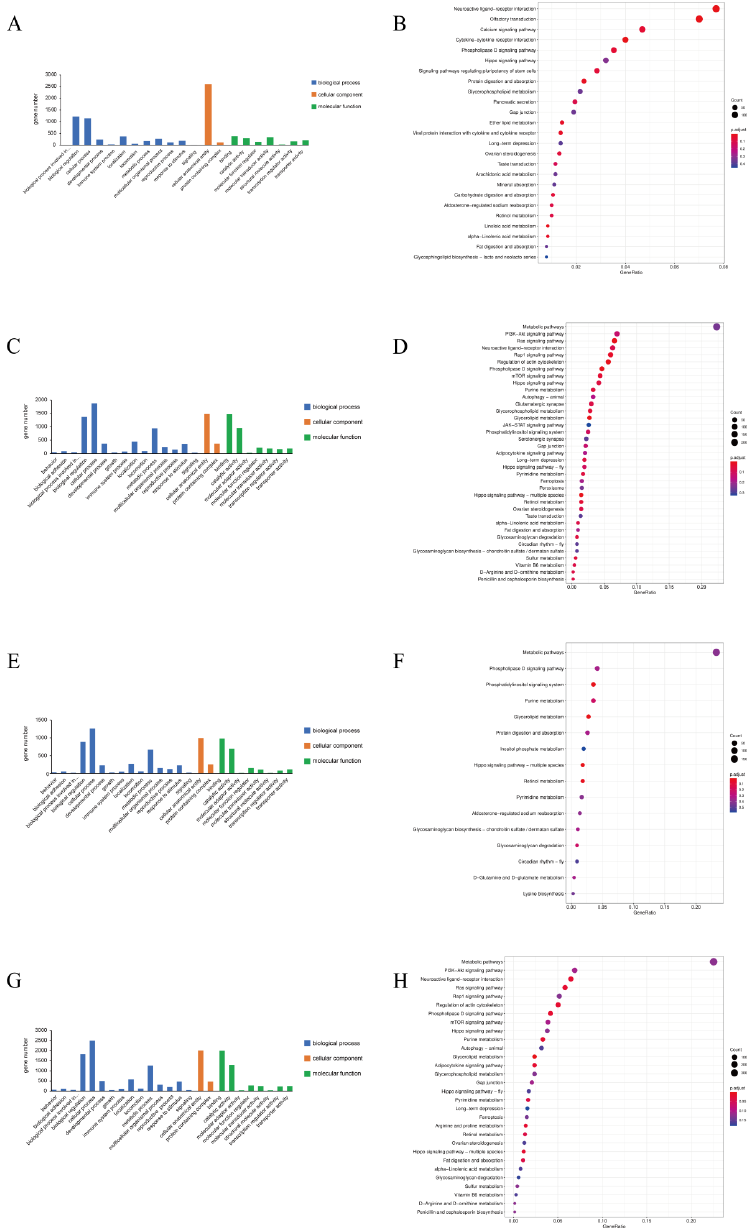
Figure 2. Analyses of functions and pathways of DE mRNAs and ncRNAs. ( A , C , E , G ) signify the GO terms of DE mRNAs, DE lncRNAs, DE circRNAs, and DE miRNAs, respectively. ( B , D , F , H ) illustrate the KEGG signaling pathways of DE mRNAs, DE lncRNAs, DE circRNAs, and DE miRNAs,